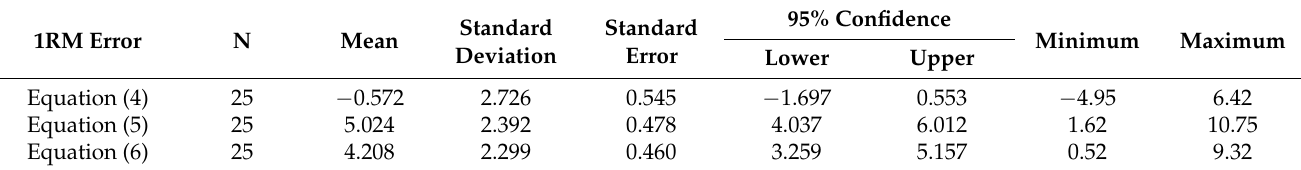
Table 6. Descriptive statistics of 1RM errors calculated from the three 1RM equations.